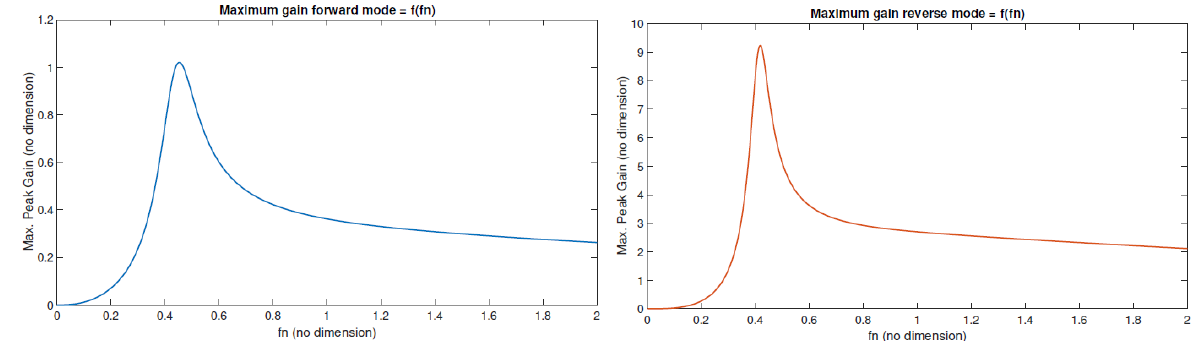
Figure 10. Gain curve for variable values of k and g in ( left ) forward direction, ( right ) reverse direction.